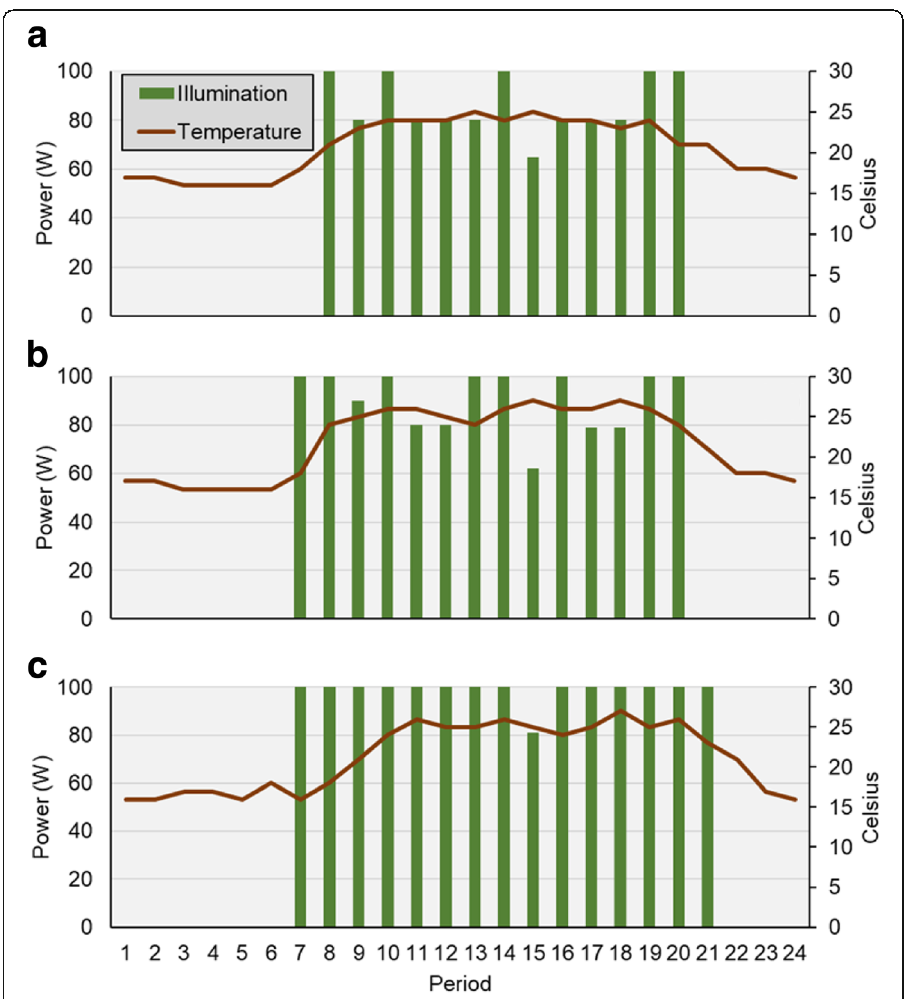
Fig. 9 Illumination intensity and temperature during consumption reduction by optimization: a office N102 – Zone 1, b office N105 – Zone 2, c office N107 – Zone